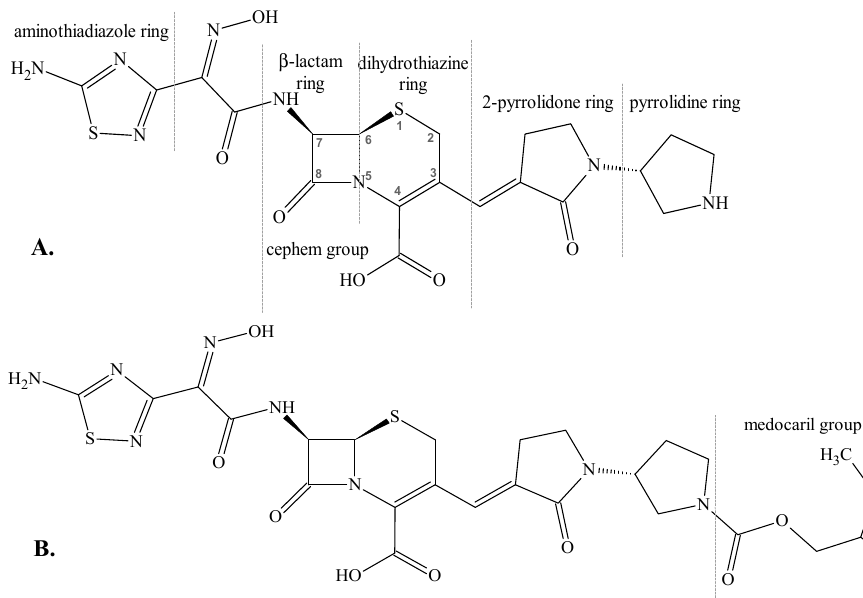
Figure 1. Molecular structures of ceftobiprole ( A ) and ceftobiprole medocaril ( B ).